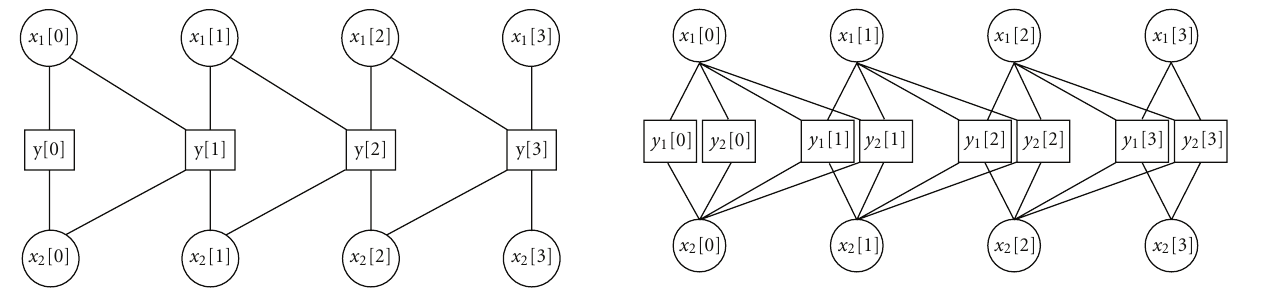
Figure 7: Factor graph of a MIMO-ISI channel with independent Gaussian approximation, N T = N R = 2, L =